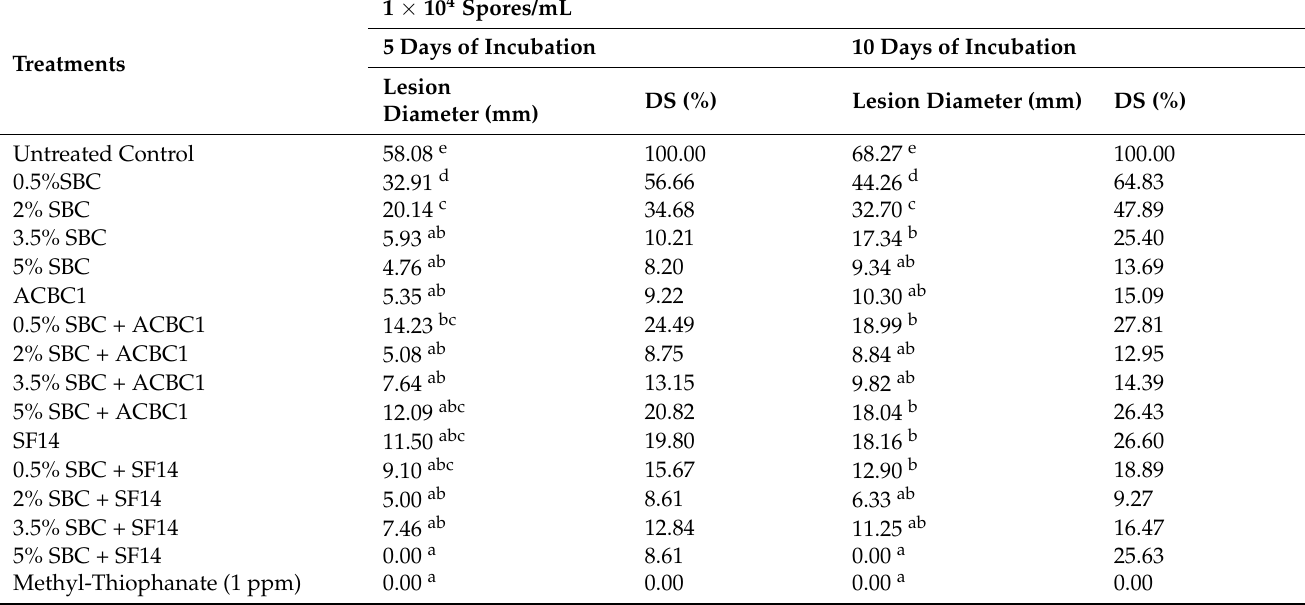
Table 3. Disease Severities (DS%) of brown rot on nectarines artificially wound-inoculated ( M. fructigena at 1 × 10 4 conidia/mL) obtained by sodium bicarbonate, antagonistic bacteria ( Bacillus amylolquefaciens SF14 and Alcaligenes faecalis (ACBC1), and their combinations after 5 and 10 days of incubation at 22 ◦